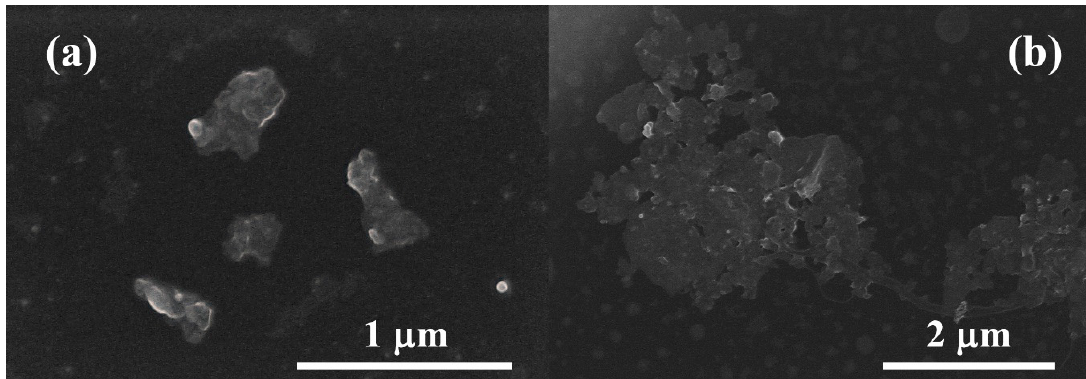
Figure 1. High-resolution scanning electron microscopy (HRSEM) images for the electrochemically exfoliated graphene nanosheets, drop-casted on a Cu transmission grid ( a ) Isolated nanosheets; ( b ) agglomerated nanosheets.